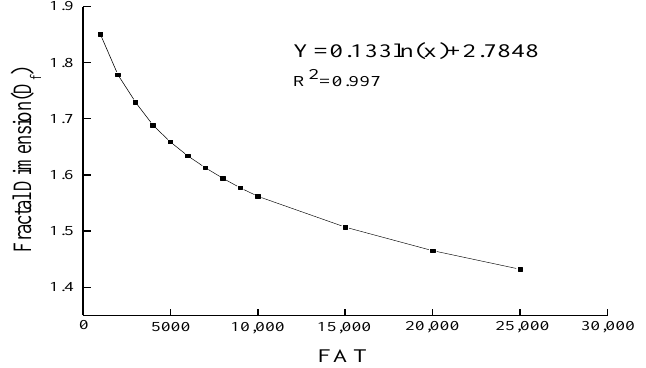
Figure 6. Graph of the fractal dimension vs. the FAT (Hubei Province) where Y and X denote the fractal dimension and the FAT, respectively.